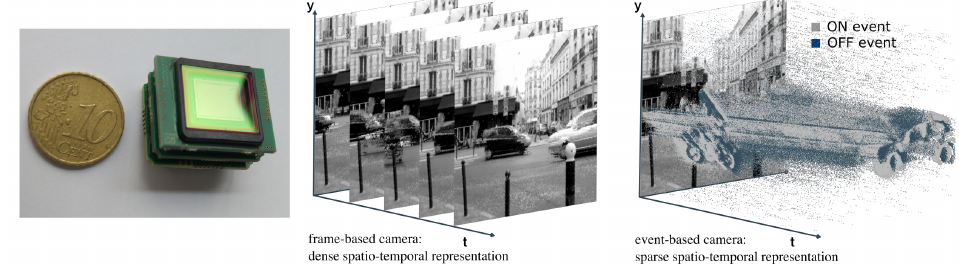
Figure 8. A miniature, event-based ATIS sensor. Contrary to a classical frame-based camera for which a full dense image representation is given at discrete, regularly spaced timings, the event- based camera provides events at the micro-second resolution. These are sparse, as they represent luminance increments or decrements (ON and OFF events, respectively). Figure courtesy of Sio-Hoi Ieng (Sorbonne Université/UPMC, Institut de la